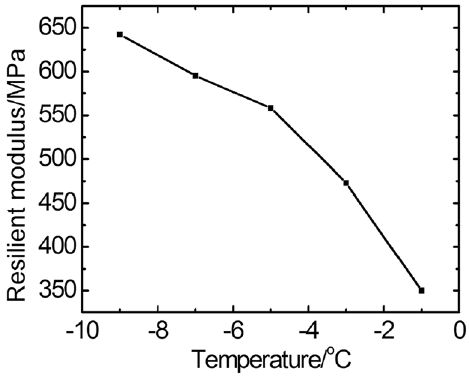
Fig. 7 Influence of the temperature on the resilient